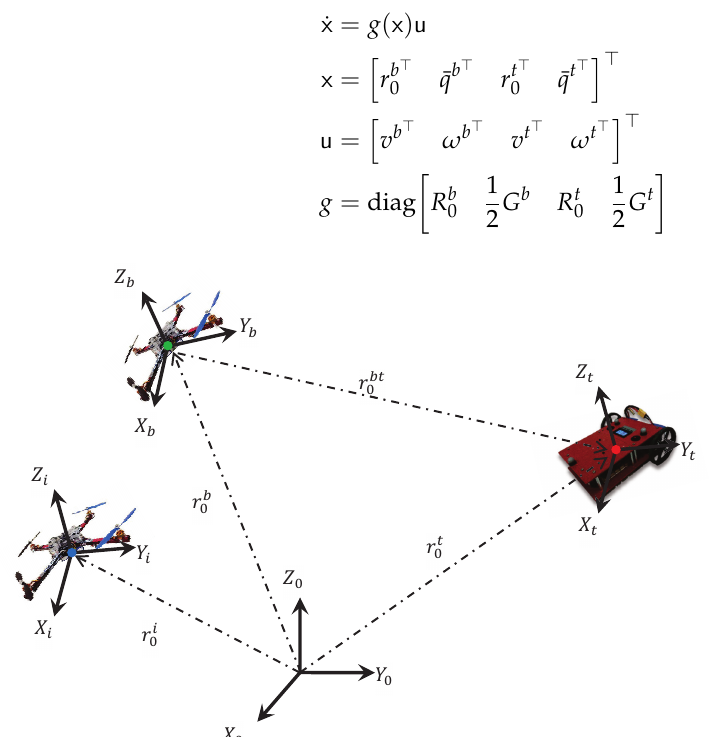
Figure 2. Pose geometry for a two-vehicle